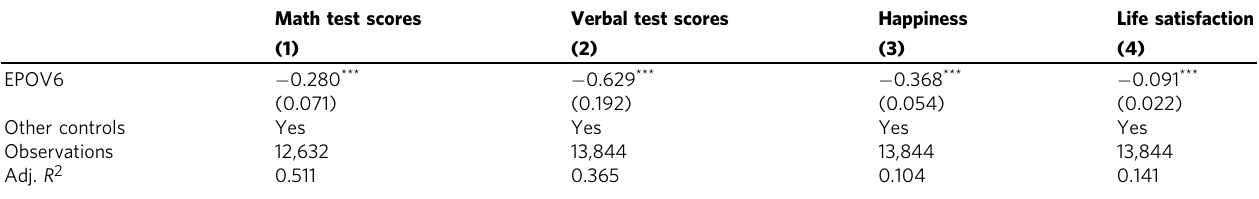
Table 6 Robustness checks (alternative measures of CH and MH).